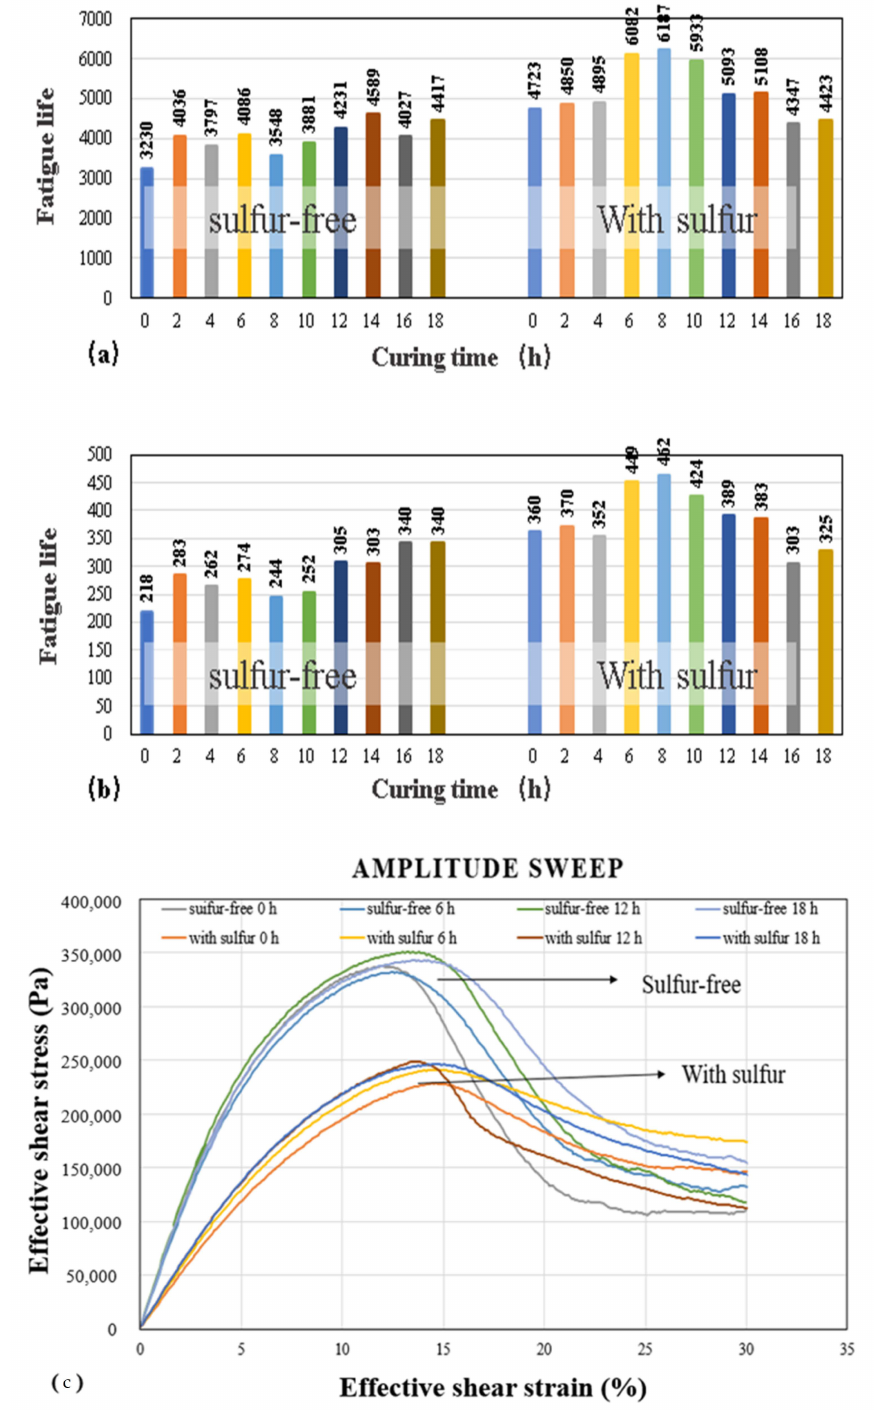
Figure 11. The effect of sulfur on SBS-modified asphalt LAS test. ( a ) 5% strain, ( b ) 15% strain, ( c ) amplitude